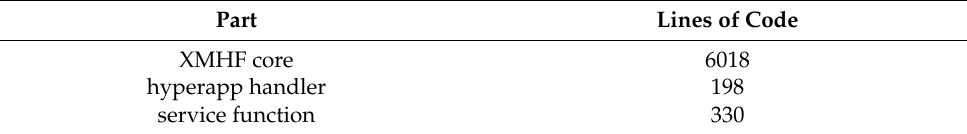
Table 1. Lines of code in the implemented